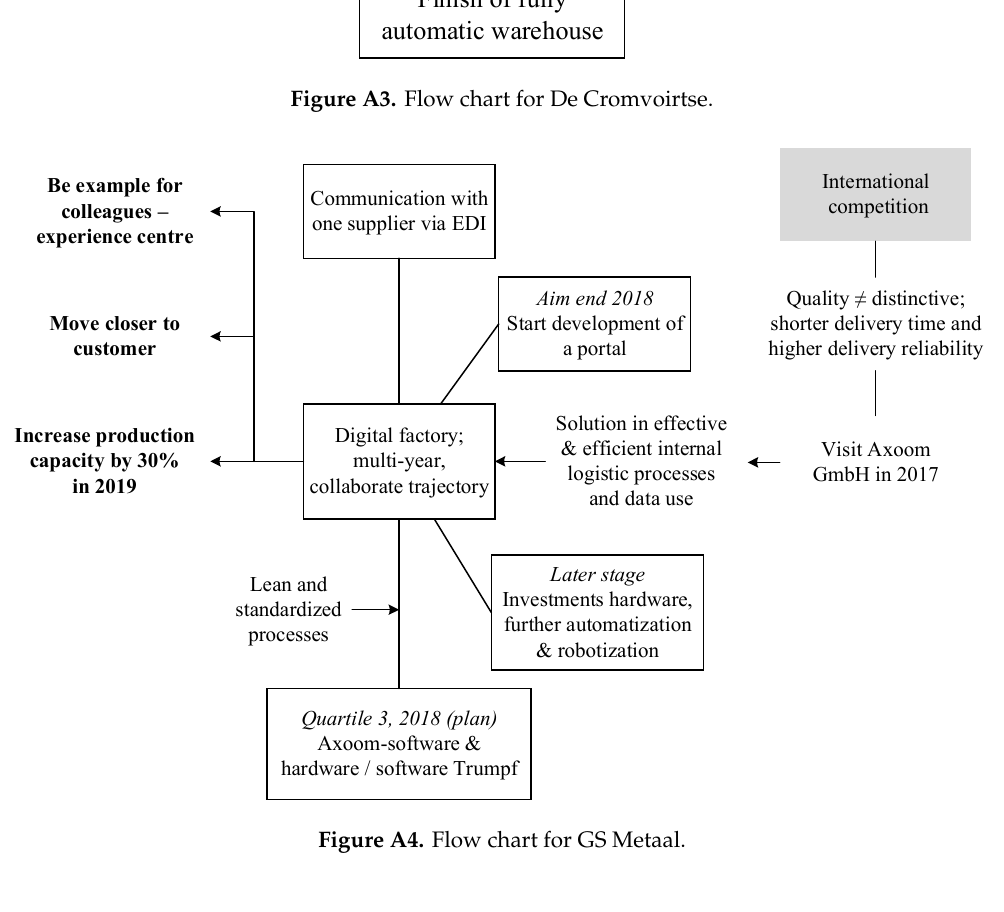
Figure A4. Flow chart for GS Metaal.